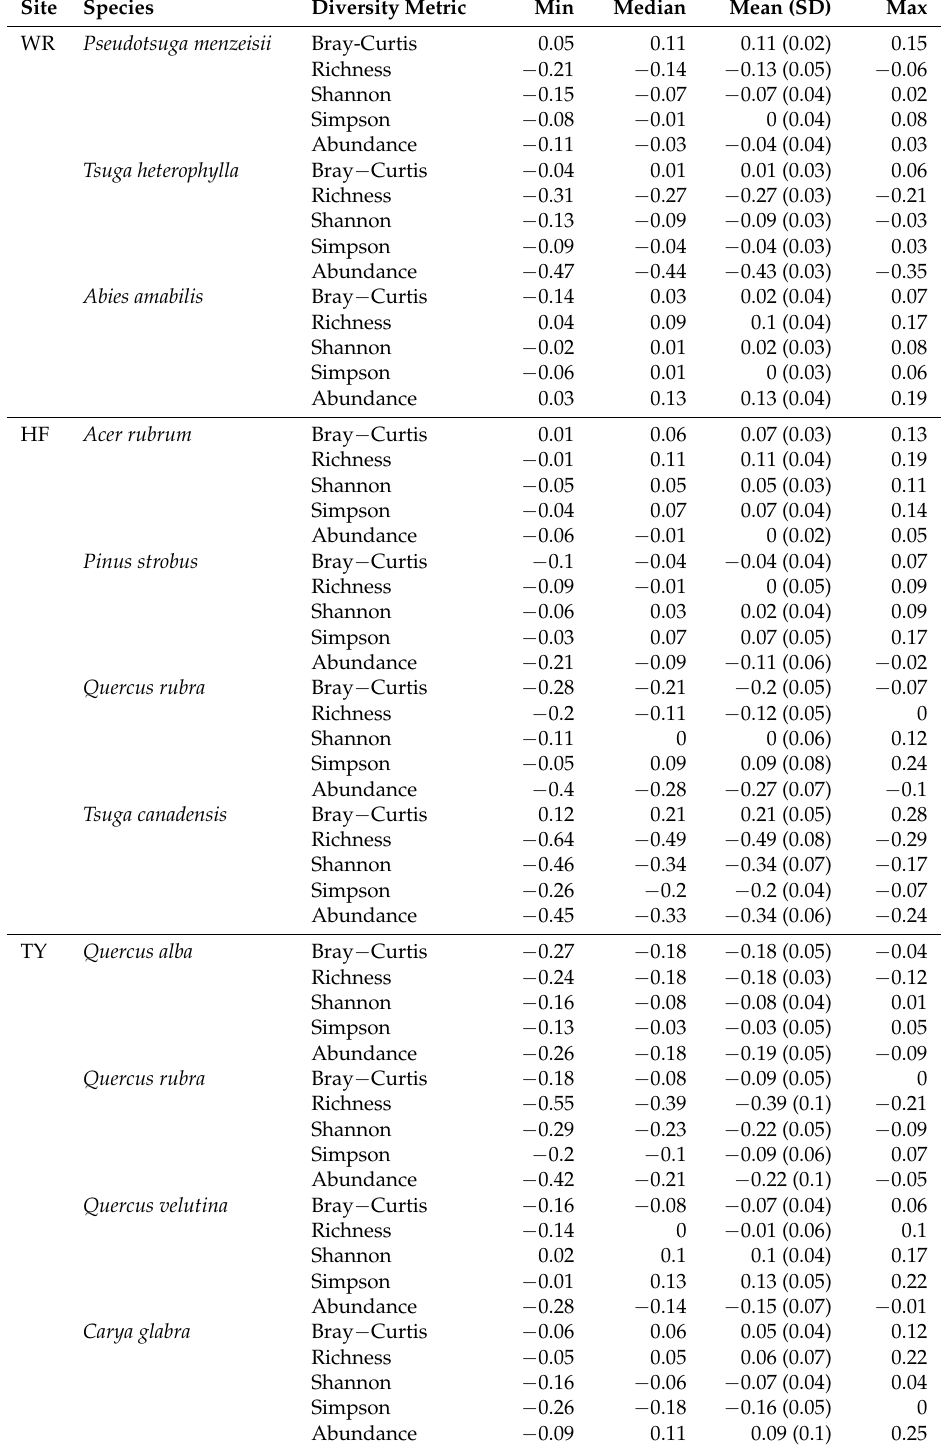
Table A1. Codispersion statistics for focal tree species in temperate forests (Figures 8–20 and Figures A1 and